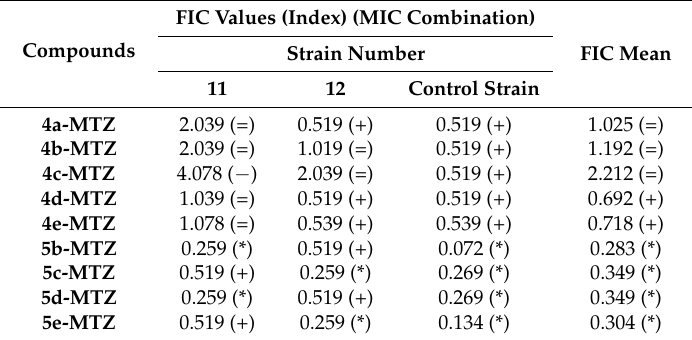
Table 3. Fractional inhibitory concentration (FIC) values of tested compounds in combination with metronidazole against clinical strains of H. pylori (11, 12) and control strain by standard checkerboard titration method with two-fold serial agar